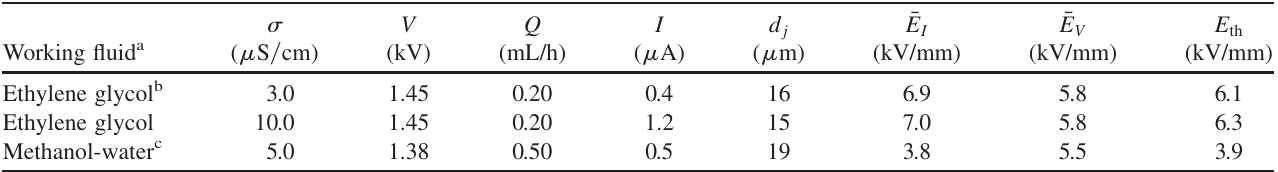
NONCLOGGING RESISTIVE PULSE SENSING WITH . . TABLE I. Selected experimental conditions for stable cone-jet bridges compared to the theoretical stability threshold ( E th ).